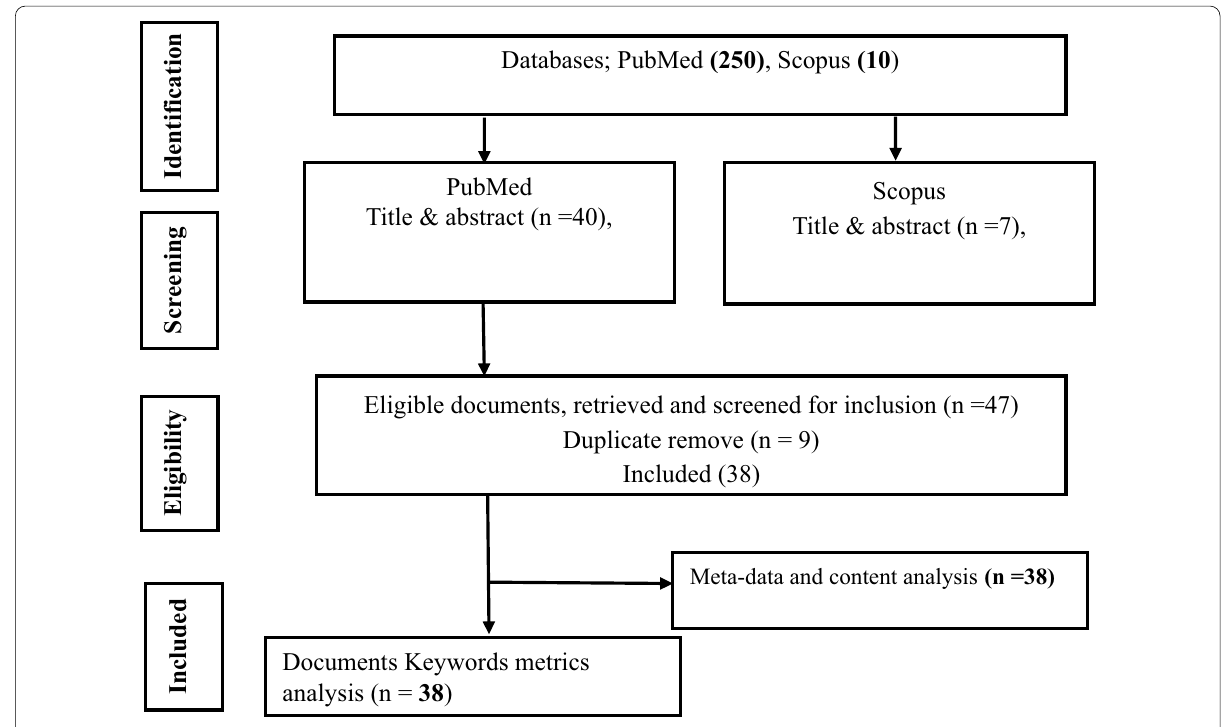
Fig. 1 PRISMA strategy and flowchart of searching, reviewing and selecting of articles on Wastewater AND Cell free nucleic acid OR extra-chromosomal DNA OR exogenous DNA OR membrane